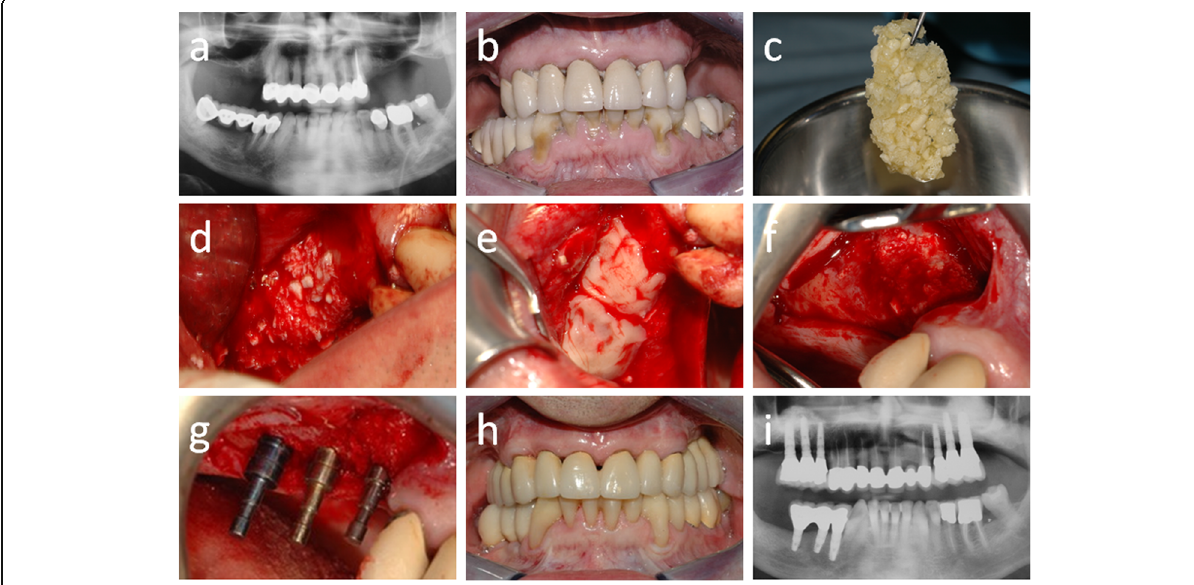
Fig. 3 A representative clinical case (Patient #6, bilateral sinus augmentation). a The pre-operative panoramic X-ray. b The clinical appearance at presentation. c The EDEB/PRGF mixture. d The augmentation is complete. e The antrostomy is sealed using the fibrin membrane. f The bone ridge 4 months later at g implant placement. h The definitive rehabilitation. i 50-month control panoramic